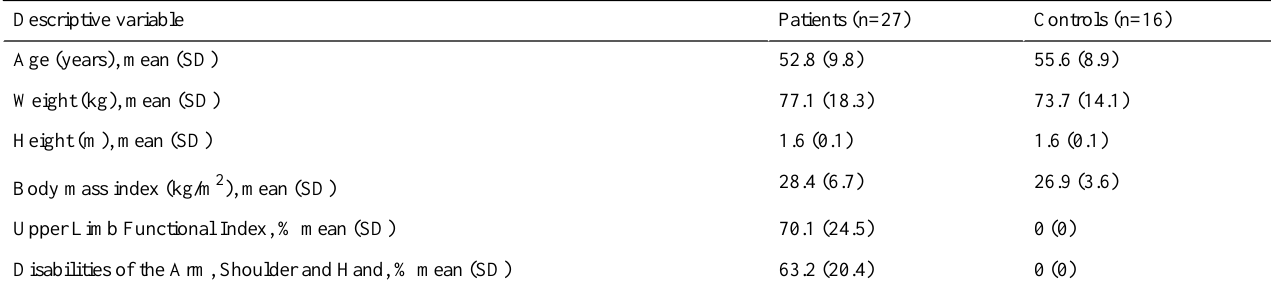
Table 2. Characteristics of